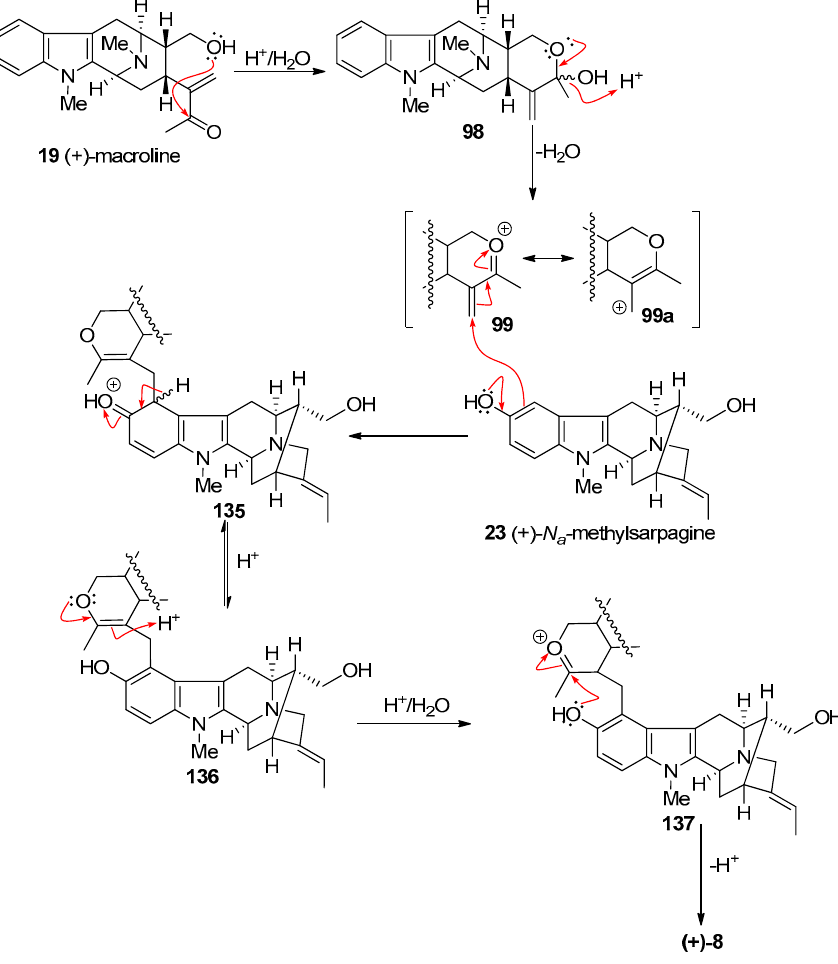
Figure 9. The possible alternative mechanism for the formation of (+)- 8 via a Friedel-Crafts alkylation process.